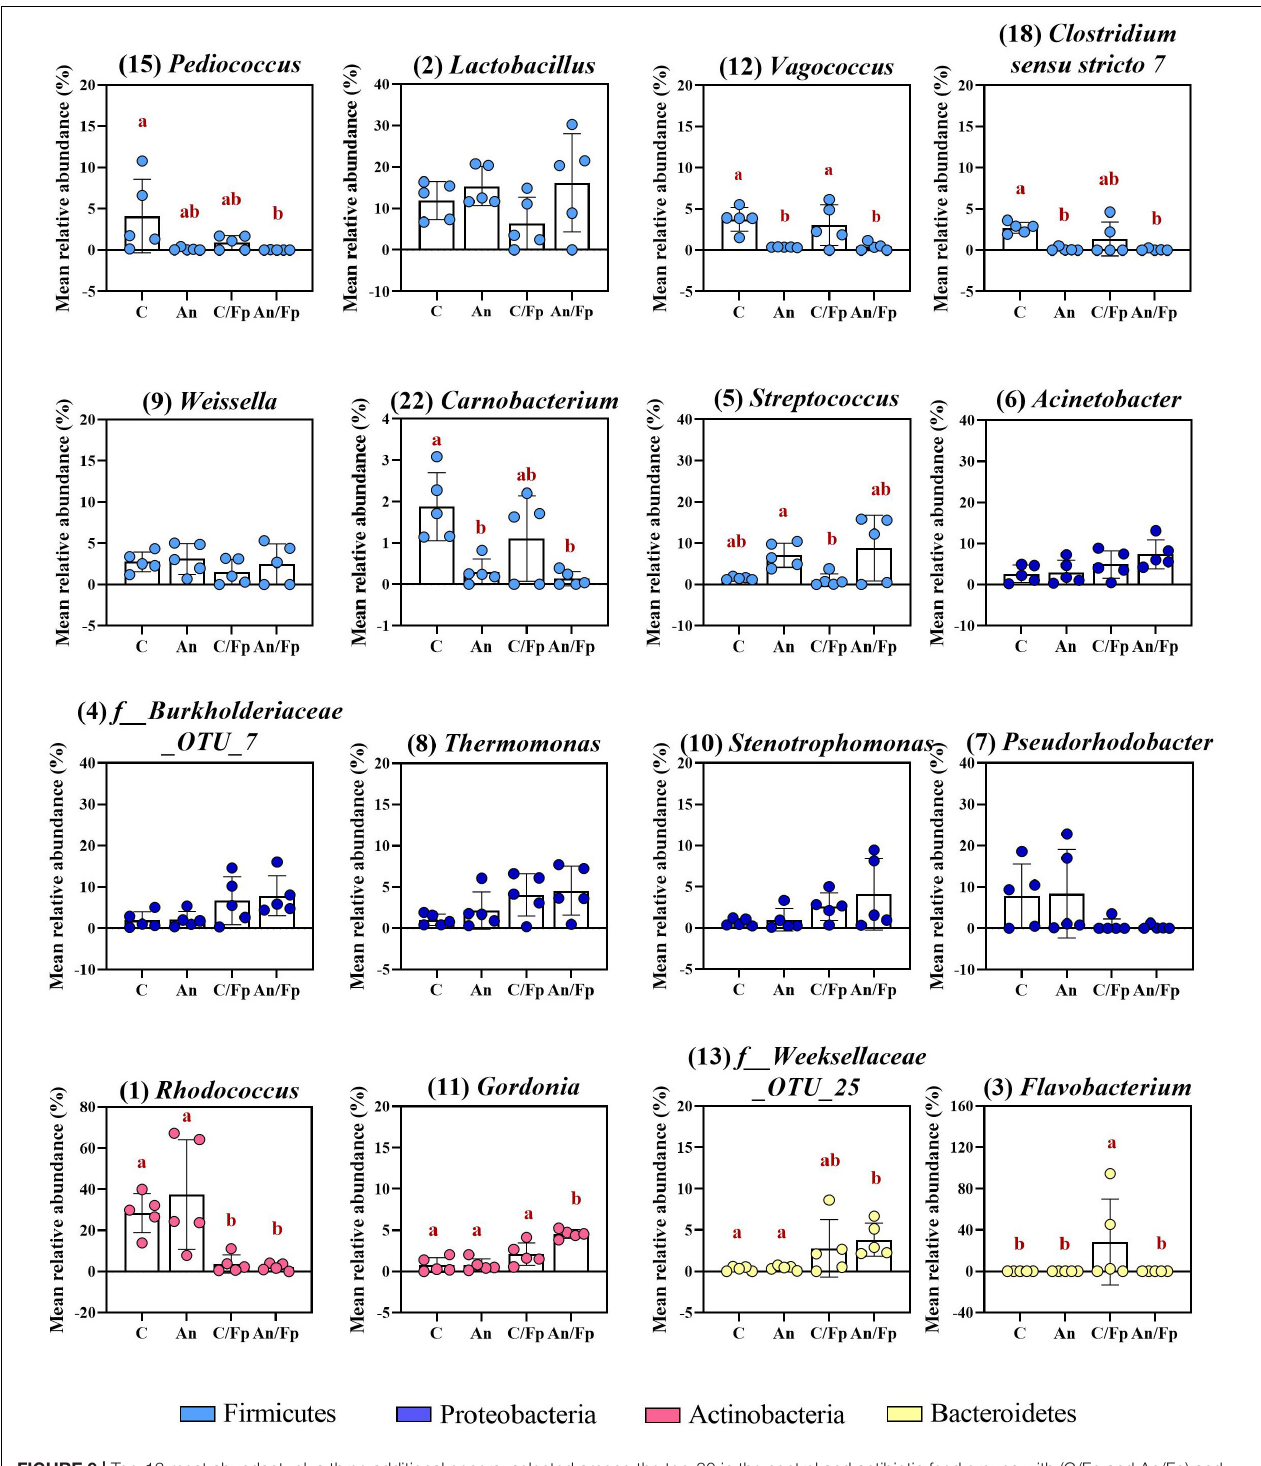
FIGURE 9 | Top-13 most abundant, plus three additional genera, selected among the top-30 in the control and antibiotic feed groups with (C/Fp and An/Fp) and without (C and An) bacterial exposure (8 dpi). The selection of the additional genera was based on previously observed abundances (among top-13 at day -1). The number in parenthesis states the position of the genus in the ranking. Values represent the mean and SD of five samples. Differences are tested by ANOVA or Kruskal–Wallis ( P -values are adjusted for multiple comparison). When significant, differences are presented with different red letters. See Supplementary Table 10 for more information on the top-30 most abundant genera at day